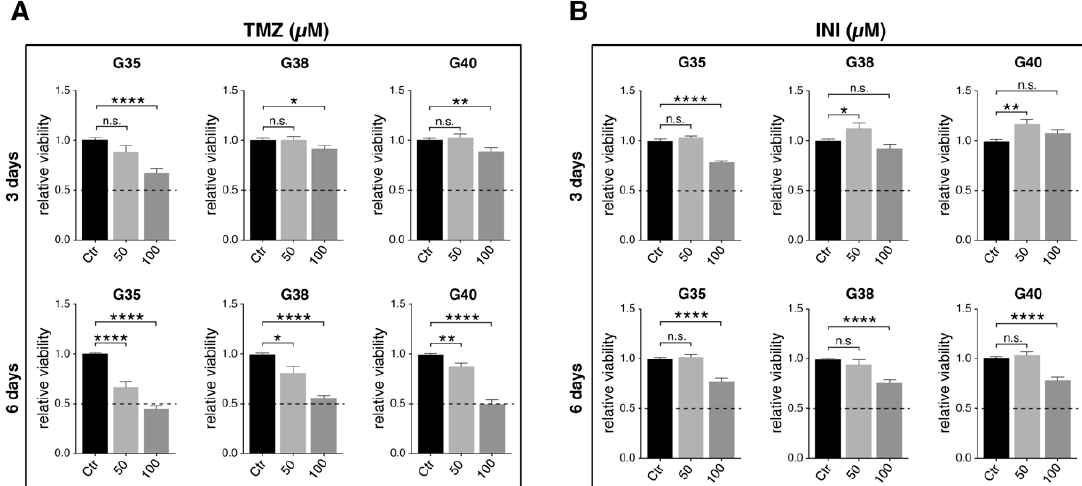
Figure 2. Determination of effective drug concentrations. Glioblastoma cells were treated with various concentrations of TMZ and INI. Cell viability was assessed 3 and 6 days after treatment by MTT assay (see Materials and Methods). Untreated controls were defined as 100%. Mean of relative cell viability of three independent experiments performed in triplicate are depicted. Two-tailed t -test was performed for comparison between different time points of treatment for concentrations of 50 µM and 100 µM of TMZ ( A ) and INI ( B ), respectively. Dotted lines represent the IC50 levels. *, ** and **** denote p < 0.05, p < 0.01, and p < 0.0001. G, glioblastoma; IC50, half maximal inhibitory concentration; and TMZ, temozolomide.